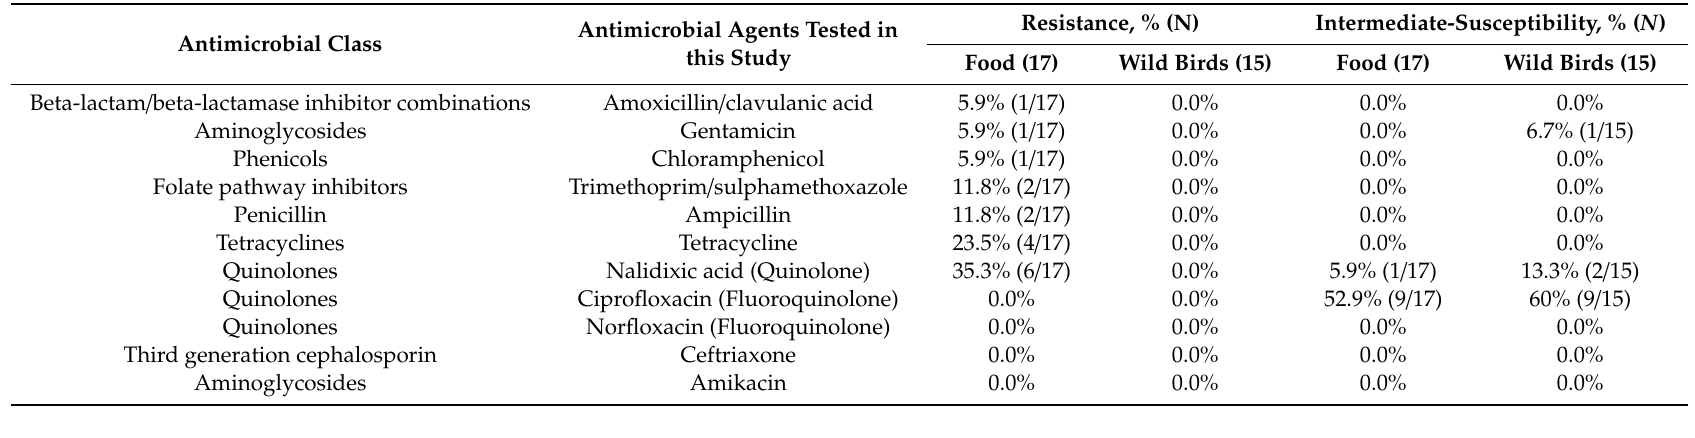
Table 3. Percentage of antimicrobial susceptibility in Salmonella isolated from cooked or ready-to-eat food and wild birds.